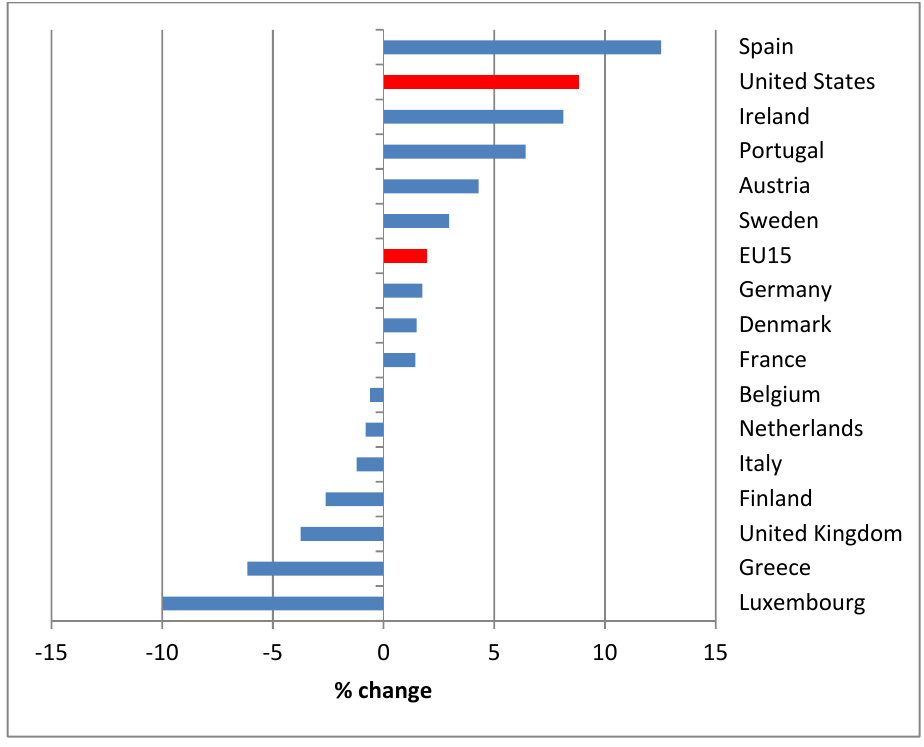
Figure 4. Percentage change in productivity 2013/2007